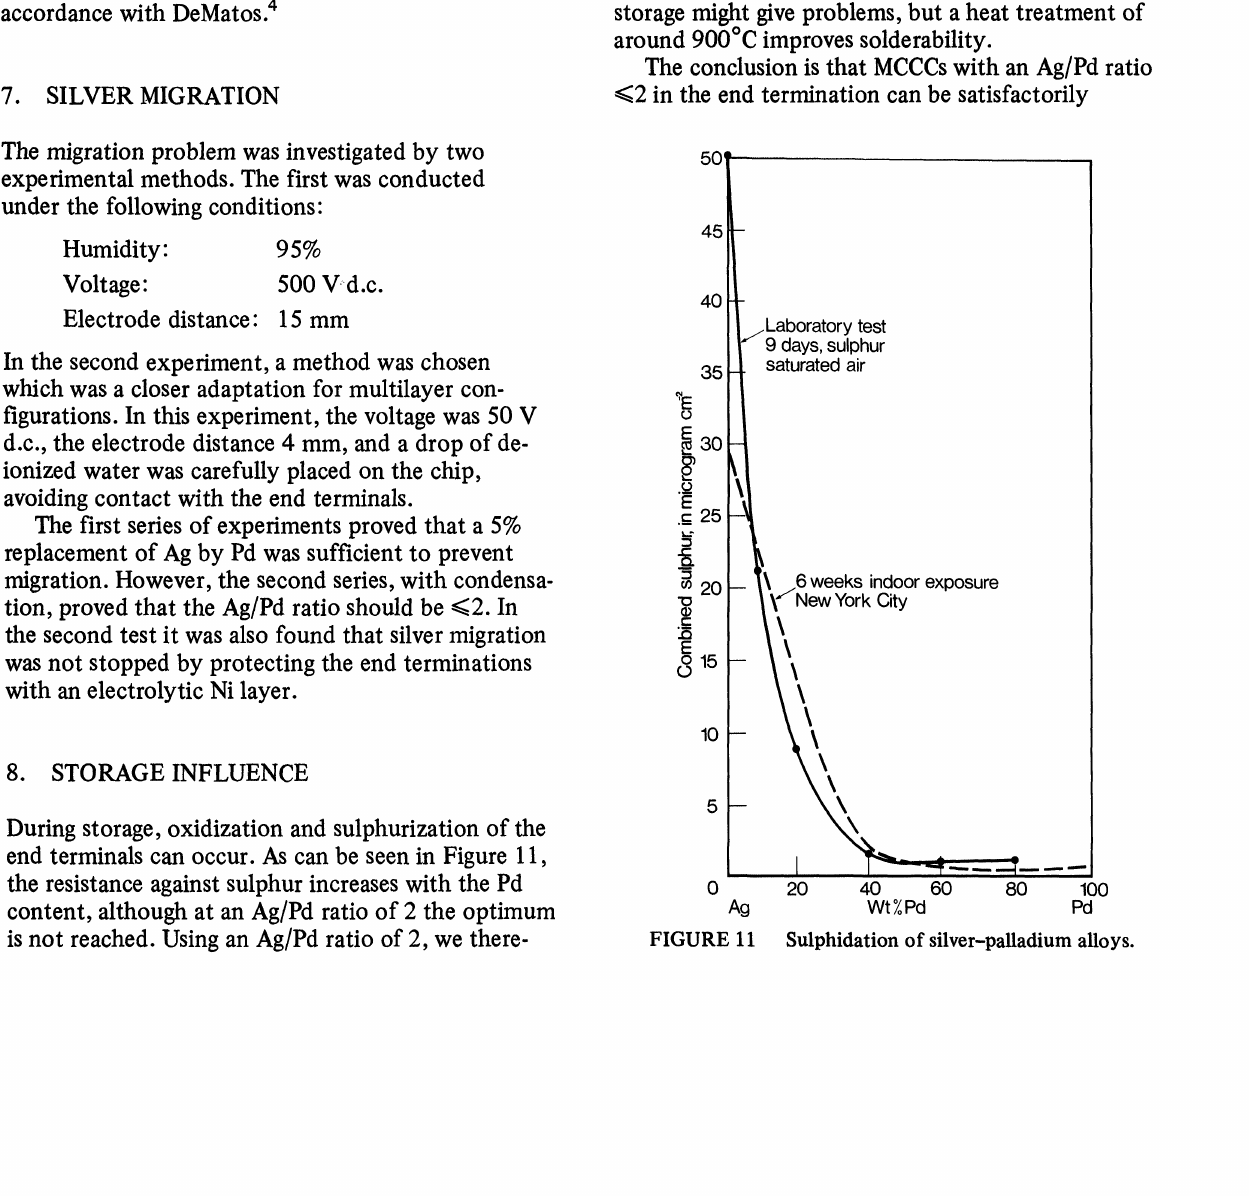
Wt 7 Pd Pd FIGURE 11 Sulphidation o f silver-palladium